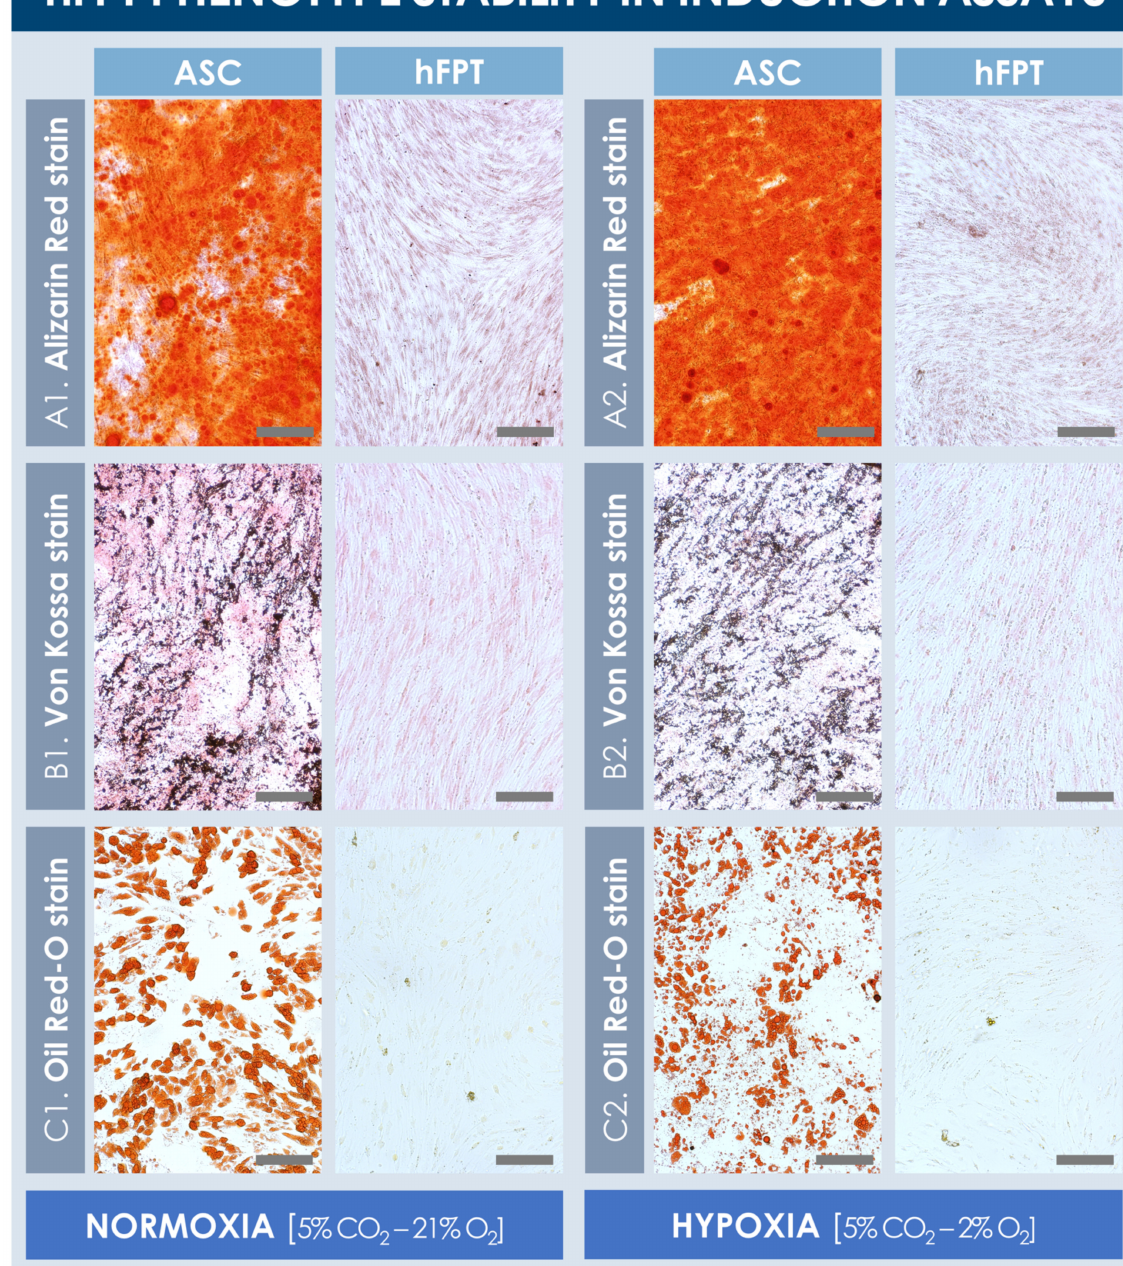
Figure 5. Comparative hFPT phenotype stability in chemical osteogenic and adipogenic induction assays. Representative imaging is provided for ASCs (i.e., positive controls) and hFPTs induced in osteogenic medium under both normoxia and hypoxia conditions, respectively, with Alizarin Red staining ( A ) or Von Kossa staining ( B ) of mineralized matrix, respectively. ( C ) Representative imaging of ASCs (i.e., positive controls) and hFPTs induced in adipogenic medium under both normoxia and hypoxia conditions, respectively, with Oil Red-O staining of lipid droplets. Scale bars = 200 µ m. ASC, adipose-derived stem cells; hFPT, human fetal progenitor